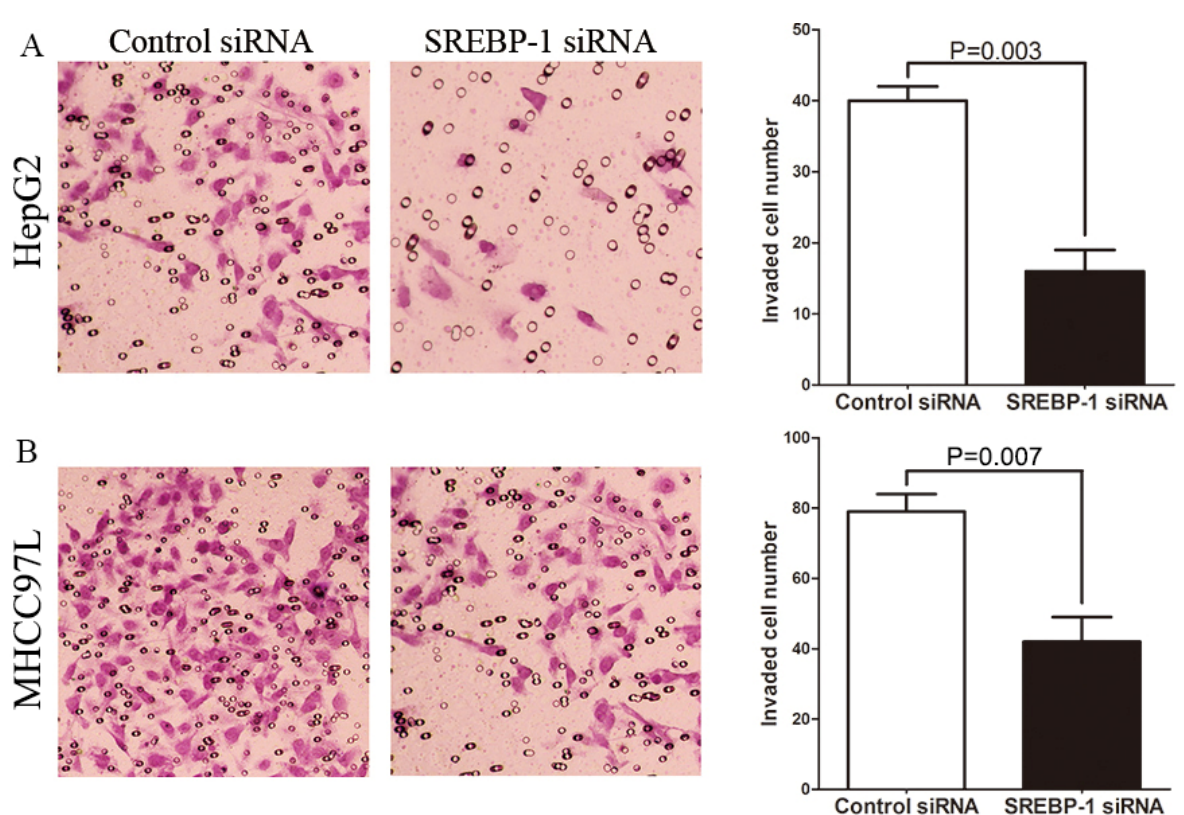
Figure 6. SREBP-1 regulates invasion of HepG2 and MHCC97L cells. ( A ) SREBP-1 knockdown decreased the number of invaded ( A ) HepG2 and ( B ) MHCC97L cells compared with control cells (original magnification ×200). n = 3. Data show representative results of repeat experiments. Values are depicted as mean ±